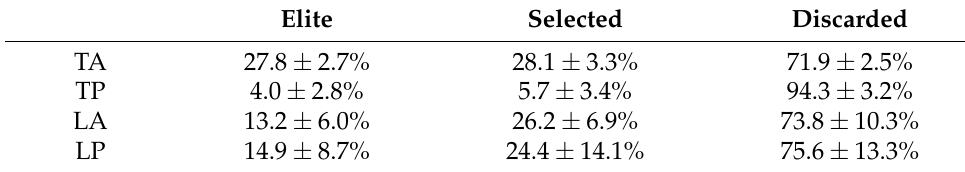
Figure 6. Learning curves of different methods in training against the four baseline opponents: ( a ) TA, ( b ) TP, ( c ) LA, ( d ) LP. Table 1. Selection rate for transferred RL agents within the NE